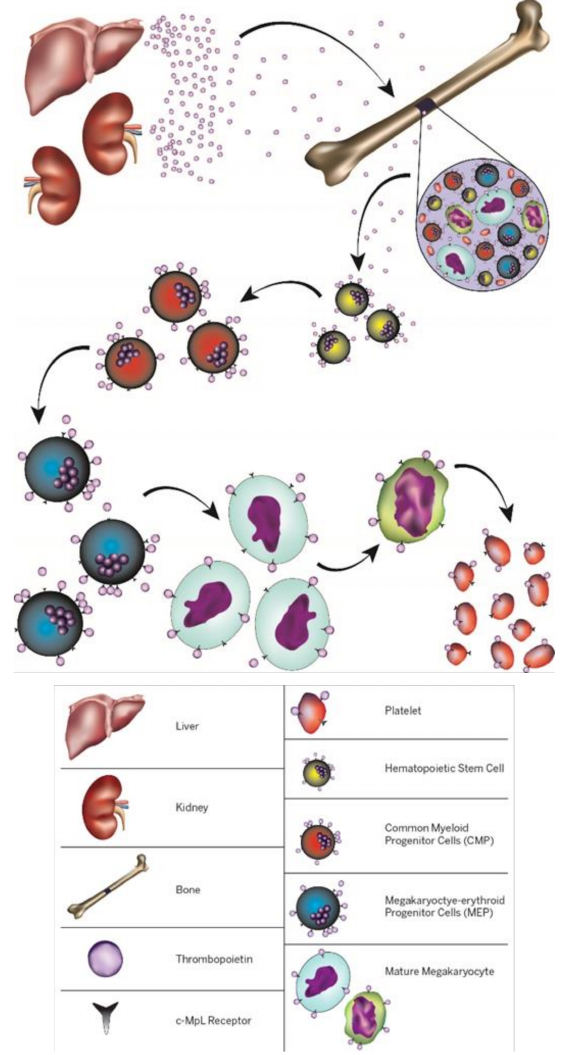
Figure 2. A schematic of MKs production. MKs are hematopoietic cells responsible for